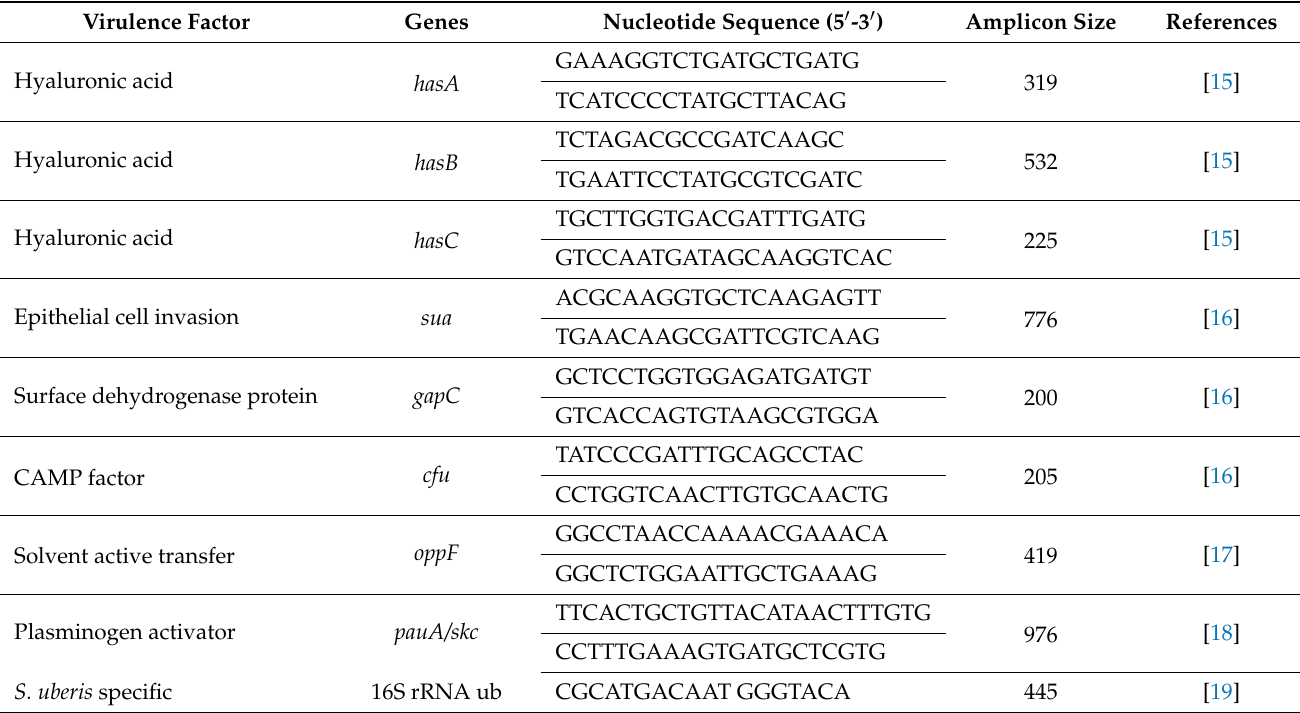
Table 1. Oligonucleotide primers used in this study for S. uberis gene detection. Genes Nucleotide Sequence (5 (cid:48) -3 (cid:48)